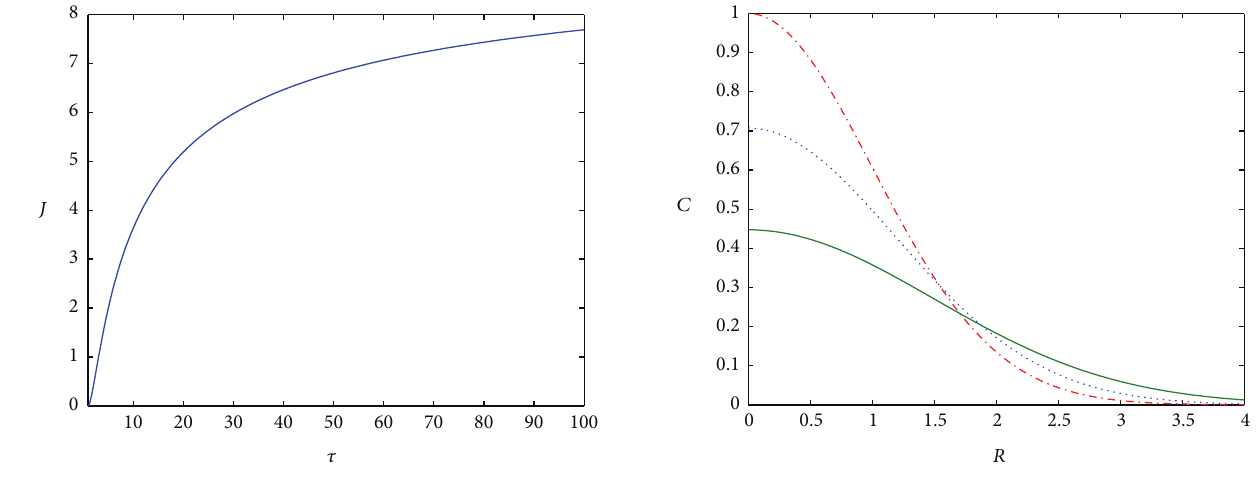
Figure 2: Solute flux across a fixed radius. Here 𝑅 𝑎 = 4 and 𝐶 0 = 10 .